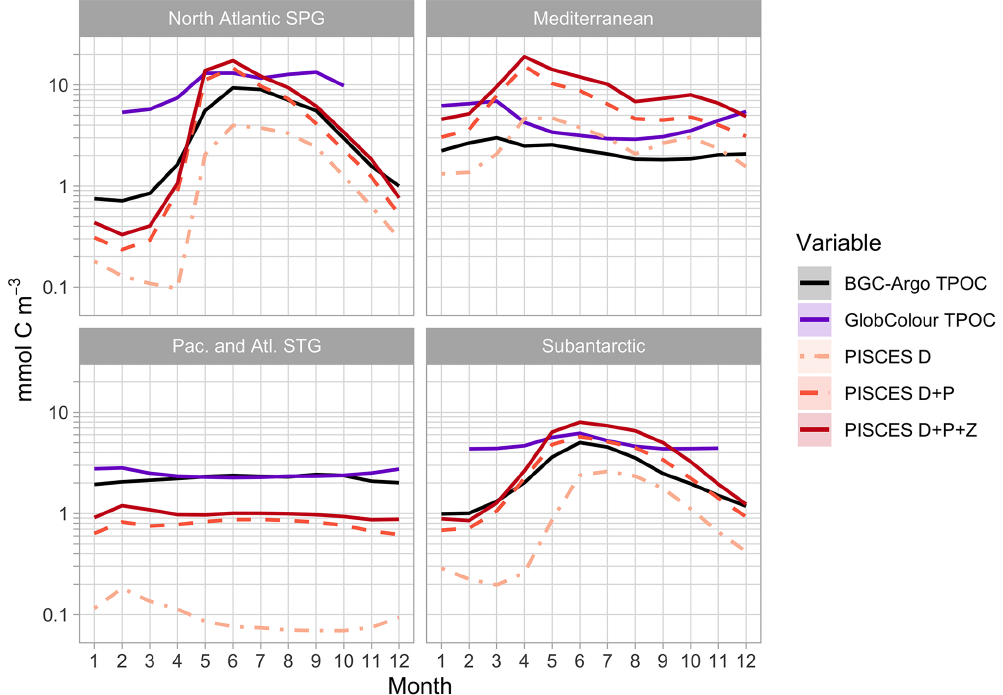
Figure 3. Monthly sea-surface particulate organic carbon (POC) concentration at the sea surface. Shown are POC estimates based on BGC- Argo (derived from the backscattering coefficient at 700nm, b bp700 ), satellite (GlobColour), and PISCES. PISCES TPOC results from the addition of the detritus (D), phytoplankton (P), and zooplankton (Z) tracers (Table 2), which are shown here as cumulative sums. Satellite data not shown for months when more than half of the ocean pixels could not be observed because of low solar elevation at high latitudes.